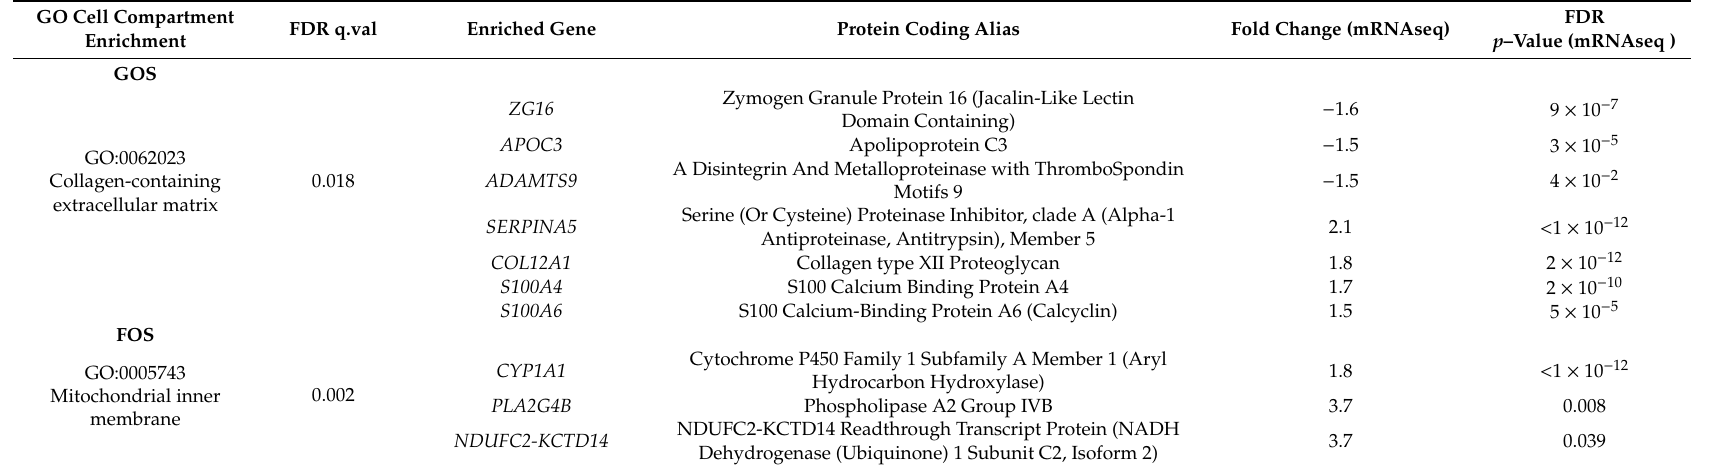
Table 6. Cell compartment GO enrichment analysis of di ff erentially expressed